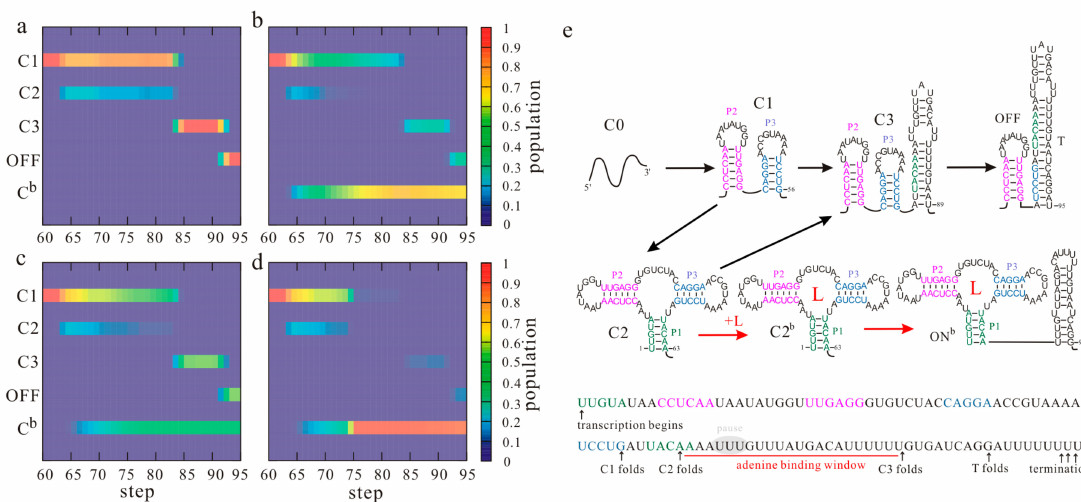
Figure 2. The ligand-dependent co-transcriptional folding behaviors of the pbuE riboswitch. The population kinetics of main structures from step 60 under different transcription conditions are shown: 20 nt/s, 0 µ M adenine ( a ); 20 nt/s, 100 µ M adenine ( b ); 50 nt/s, 100 µ M adenine ( c ); 50 nt/s, 100 µ M adenine with pausing (60 s) at step 67 ( d ). The superscript “b” denotes the corresponding state with the ligand bound and C b denotes the ensemble of all the bound states. Main co-transcriptional folding pathways and folding events are mapped in ( e ). T is the terminator hairpin; L is the ligand (adenine). Nucleotides within paired regions of the aptamer structure are colored